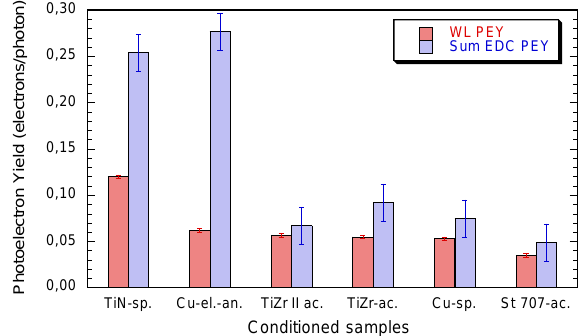
FIG. 19. (Color) A comparison between WL PY and its corresponding low photon dose WL PY generated from a summation of the acquired EDCs for the conditioned samples. Error bars are those generated from the Au